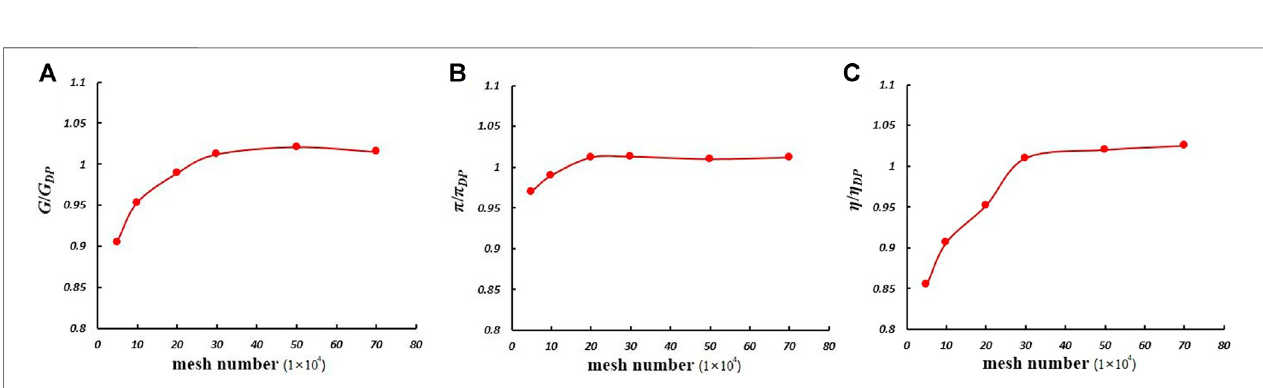
Frontiers in Energy Research |